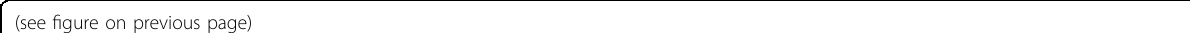
Fig. 5 Neurog2-iN cells exhibit mature electrophysiological properties and receive peripheral inputs from dorsal root ganglion. a , b Membrane properties of an mCherry + astrocyte recorded in an acute dorsal spinal cord slice prepared from a WT mouse infected with the control virus AAV – mCherry at 30 DPI. Membrane currents ( a ) and voltages ( b ) were recorded in voltage- and current-clamp modes, respectively, in responses to the step current or voltage commands. c , d Membrane functions of iN cells (mCherry + ) in slices of the dorsal spinal cord that were prepared from WT mice infected with AAV – Neurog2/mCherry at 30 DPI. Membrane currents ( c ) and membrane voltages ( d ) were recorded in voltage- and current-clamp modes, respectively. e The comparison of membrane capacitance among AAV-mCherry-infected cells (red), local neurons (purple), and AAV-Neurog2/mCherry-infected cells (light blue). A one-way ANOVA revealed a signi fi cant effect of group (F[2,31] = 48.02, p < 0.001), followed by Tukey ’ s multiple comparison test. f The comparison of input resistance among AAV-mCherry-infected cells, local neurons and AAV- Neurog2/mCherry-infected cells. A one-way ANOVA revealed a signi fi cant effect of group (F[2,31] = 11.54, p < 0.001), followed by Tukey ’ s multiple comparison test. g, h Two kinds of representative traces of APs induced by depolarization currents of Neurog2-iN cells (mCherry + ) in the slice of spinal cord. i The comparison of AP amplitude (mV) of recorded cells between local neurons and Neurog2-iN cells. Statistical analysis was performed using the two-tailed t -test method. j Schematic showing relative positions of recorded mCherry + cells. D, V, R, and C in ( j ) represent dorsal, ventral, rostral, and caudal, respectively. k The table is a summary of inputs from DRG in 51 recorded mCherry + cells from 5 mice. l Typical traces of C- fi ber- evoked mono-C and poly-C EPSCs onto mCherry + cells. m Typical traces of A δ - fi ber-evoked EPSPs and APs showing A δ fi ber inputs onto mCherry + cells. *** Represents p < 0.001, n.s. denotes not signi fi